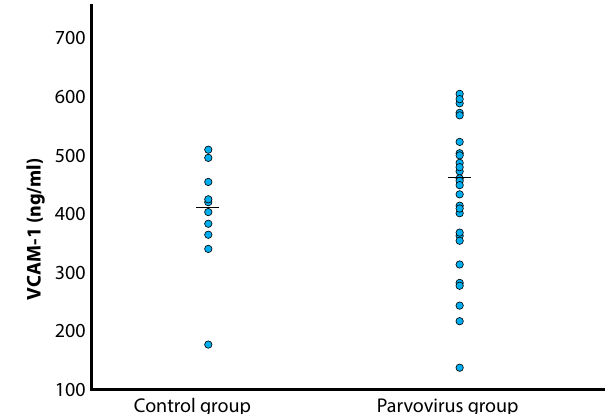
Figure 1: ICAM-1 concentrations at presentation for CPV enteritis. Black line represents the median for each group. * Significantly lower than the control group.